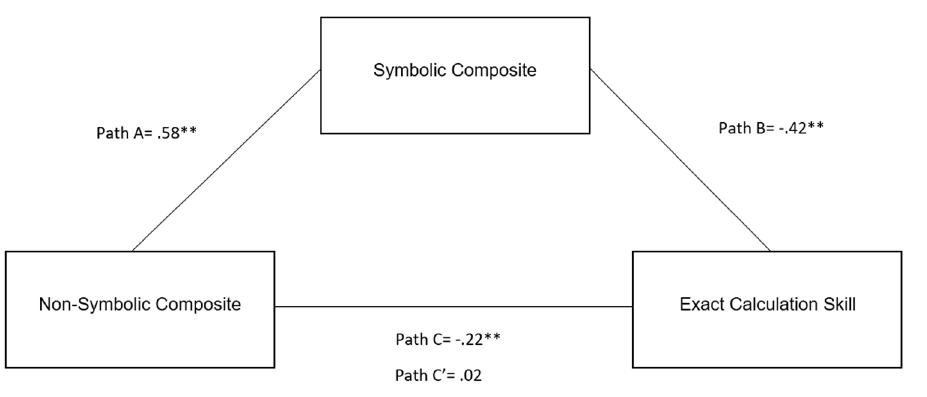
Figure 2. Mediation model of exact calculation skill, symbolic system performance and non-symbolic system performance. Beta values